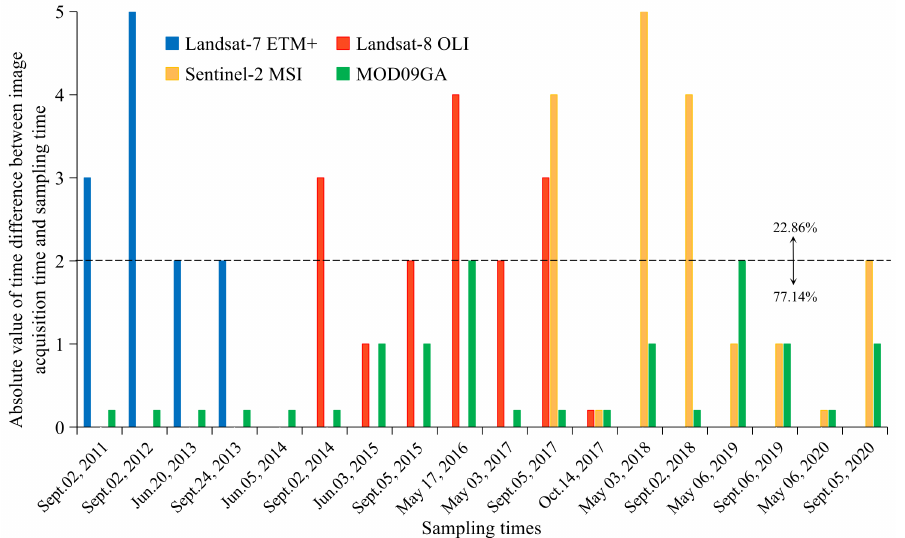
Figure 2. The absolute value of time difference between remote-sensing image acquisition time and sampling time (the time difference of 0 days is represented by 14 shortest